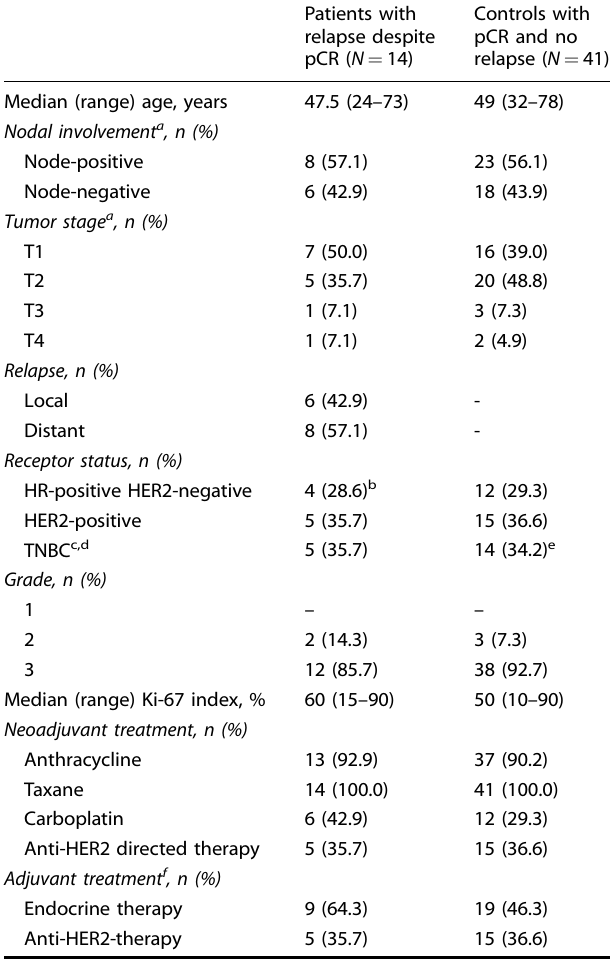
Table 1. Patient characteristics.